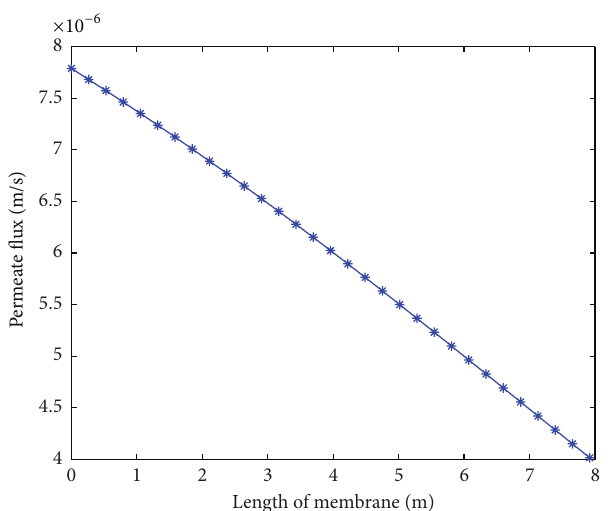
Figure 10: Concentration polarization along membrane.